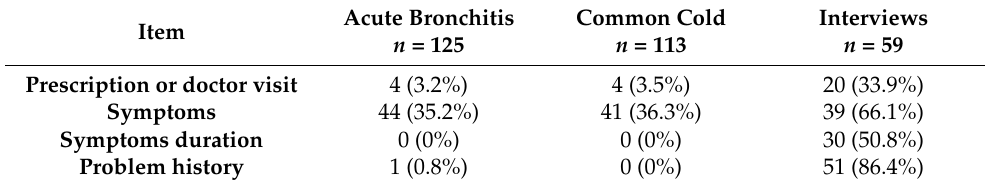
Table 4. Pharmacy staff self-reported information-gathering practices before antibiotic